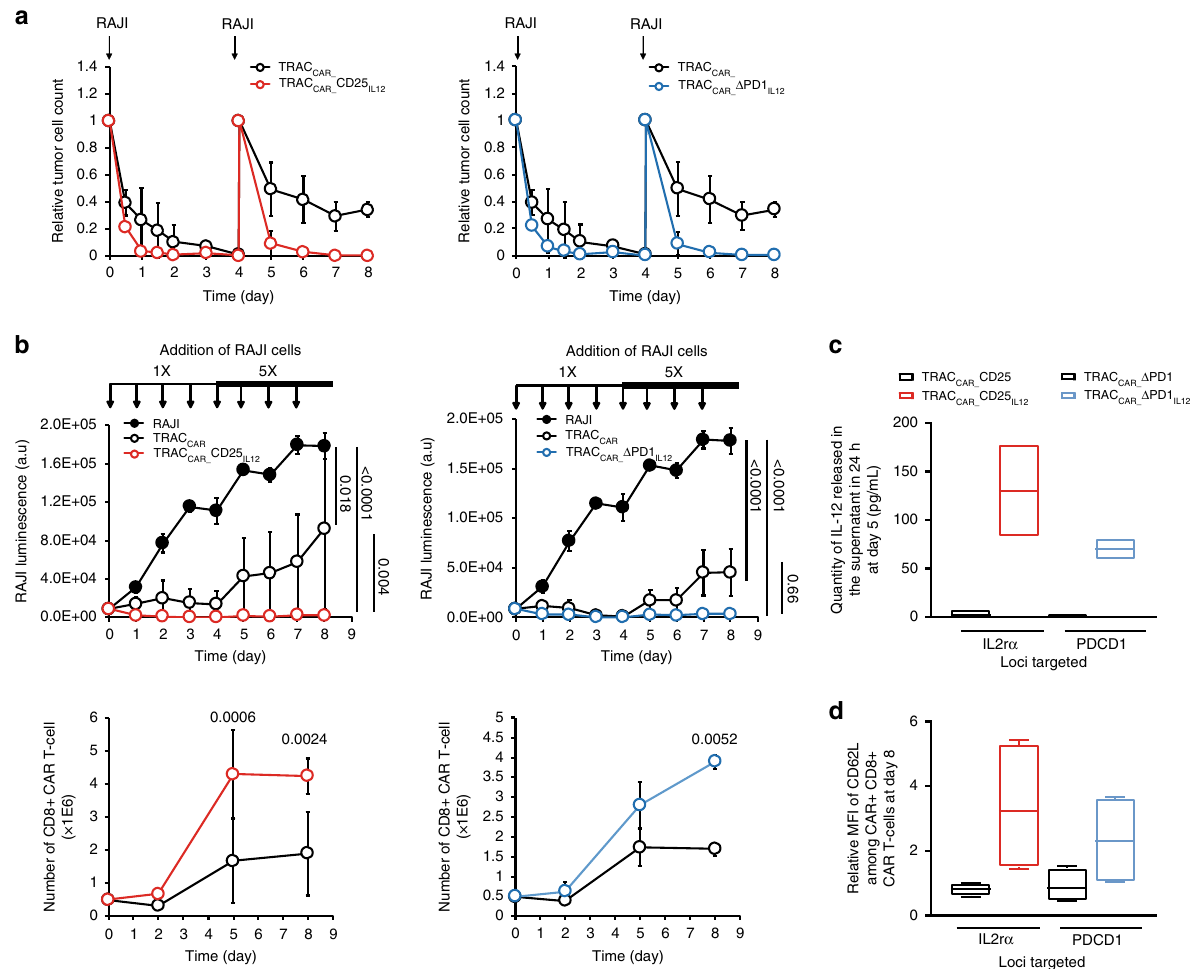
Fig. 6 Conditional secretion of IL-12P70 increases TRAC CAR T cells antitumor activity in vitro. a Kinetics of tumor cell clearance by puri fi ed TRAC CAR T cells and TRAC CAR T cells secreting IL-12P70. TRAC CAR , TRAC CAR _CD25 IL12 T cells and TRAC CAR _ Δ PD1 IL12 T cells were challenged with 1 equivalent of RAJI cells at days 0 and 4 and cultivated for 8 days. Kinetics of tumor cell disappearance was analyzed by integrating fl ow cytometry data, using CD19 antibody speci fi c for RAJI cells, and total number of cells mixture. The relative tumor cell count was computed as the ratio of remaining tumor cells at a given time to the total number of tumor cells added. b Long-term cytotoxicity assay. TRAC CAR T cells were challenged daily with RAJI cells at a ratio of T cells to tumor cells of 5-to-1. Fresh tumor cells (0.2 × 10 6 cells) were added everyday up to day 4 after pelleting and resuspended the TRAC CAR T cells in fresh culture media. From day 5 onward, 5× the original number of tumor cells (10 6 cells) was added. The antitumor activity of the TRAC CAR T cells was monitored everyday by measuring the luminescence of the remaining RAJI tumor cells expressing luciferase. Cells were counted and analyzed by fl ow cytometry on days 0, 2, 5, and 8, and the number of CD8 ( + ) CAR T cells was computed and plotted as a function of time. The data are averaged + / − standard deviation from two experiments performed with cells from two different donors. Two-way ANOVA was used in panel b for statistical analysis ( p -value are indicated). c Comparison of IL-12P70 secretion for different TRAC CAR T cell groups at day 5 of the serial killing assay. d Comparison of CD62L MFI among CD8 ( + ) CAR T cells obtained for the different TRAC CAR T cell groups at day 8 of the serial killing assay. The data shown in c and d were obtained from two experiments performed with cells from two different donors. On each box plot, the central mark indicates the median, the bottom and top edges of the box indicate the interquartile range and the whiskers represent the maximum and minimum data point. Source data are provided as a Source Data fi